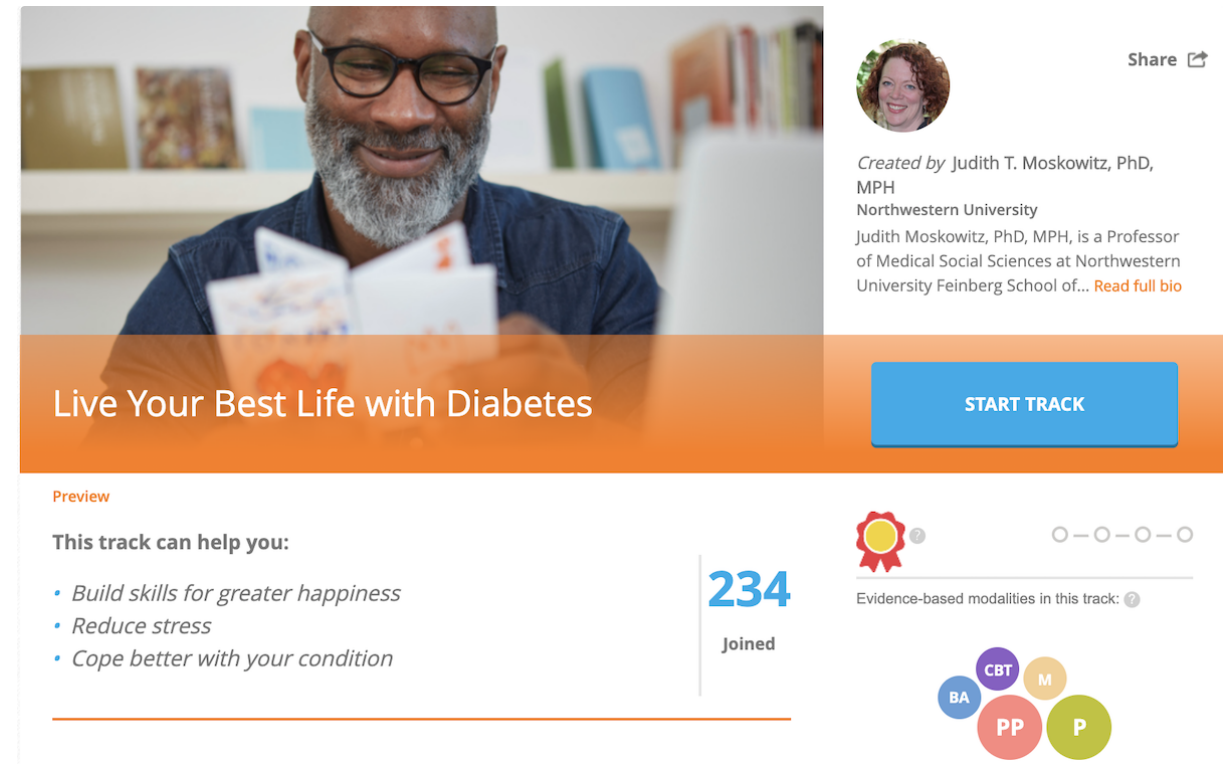
Figure 1. Screenshot of the featured track description for Developing Affective HeaLth to Improve Adherence